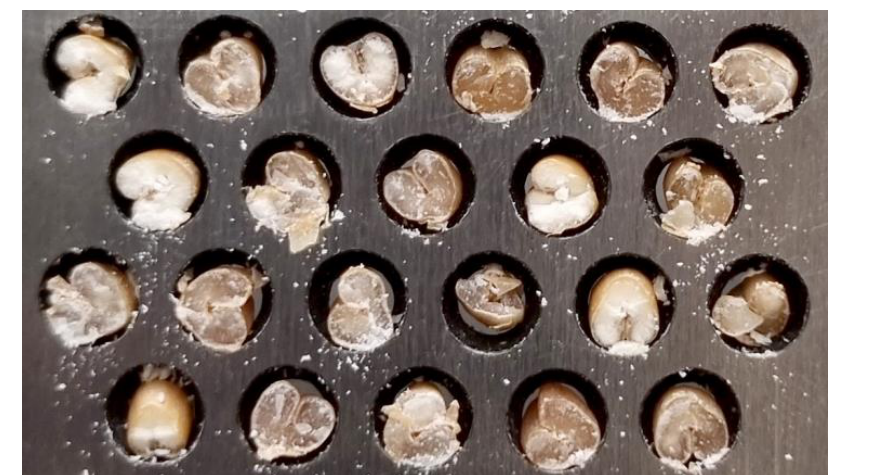
Figure 2. Commercially available Pohl’s grain cutter.